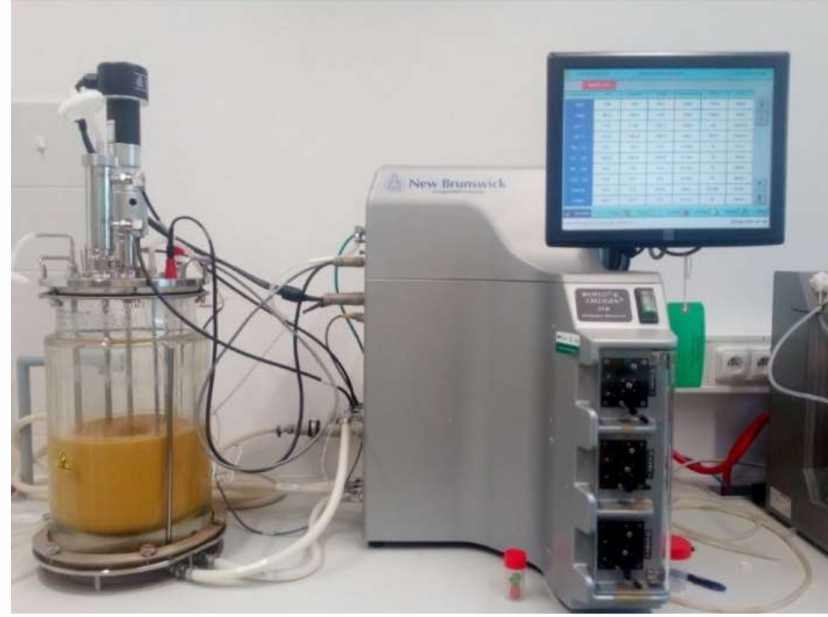
Figure 3. Bioleaching of samples in pilot plant conditions in a Bioflo & CelliGen 310